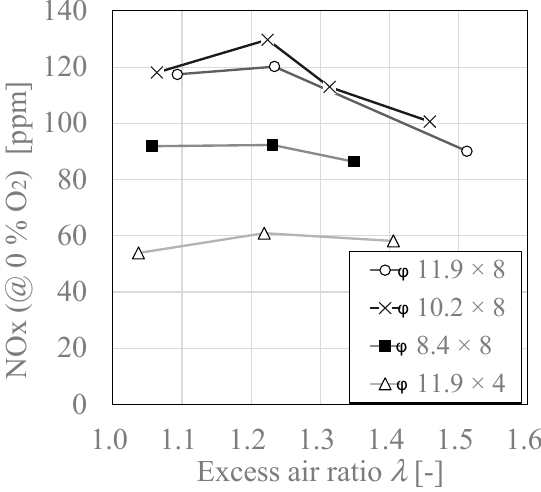
Figure 14. NOx for different λ under each air nozzle case, at 1273 K and E H2 = 100%. Input = 174 kW, P = +15 Pa.